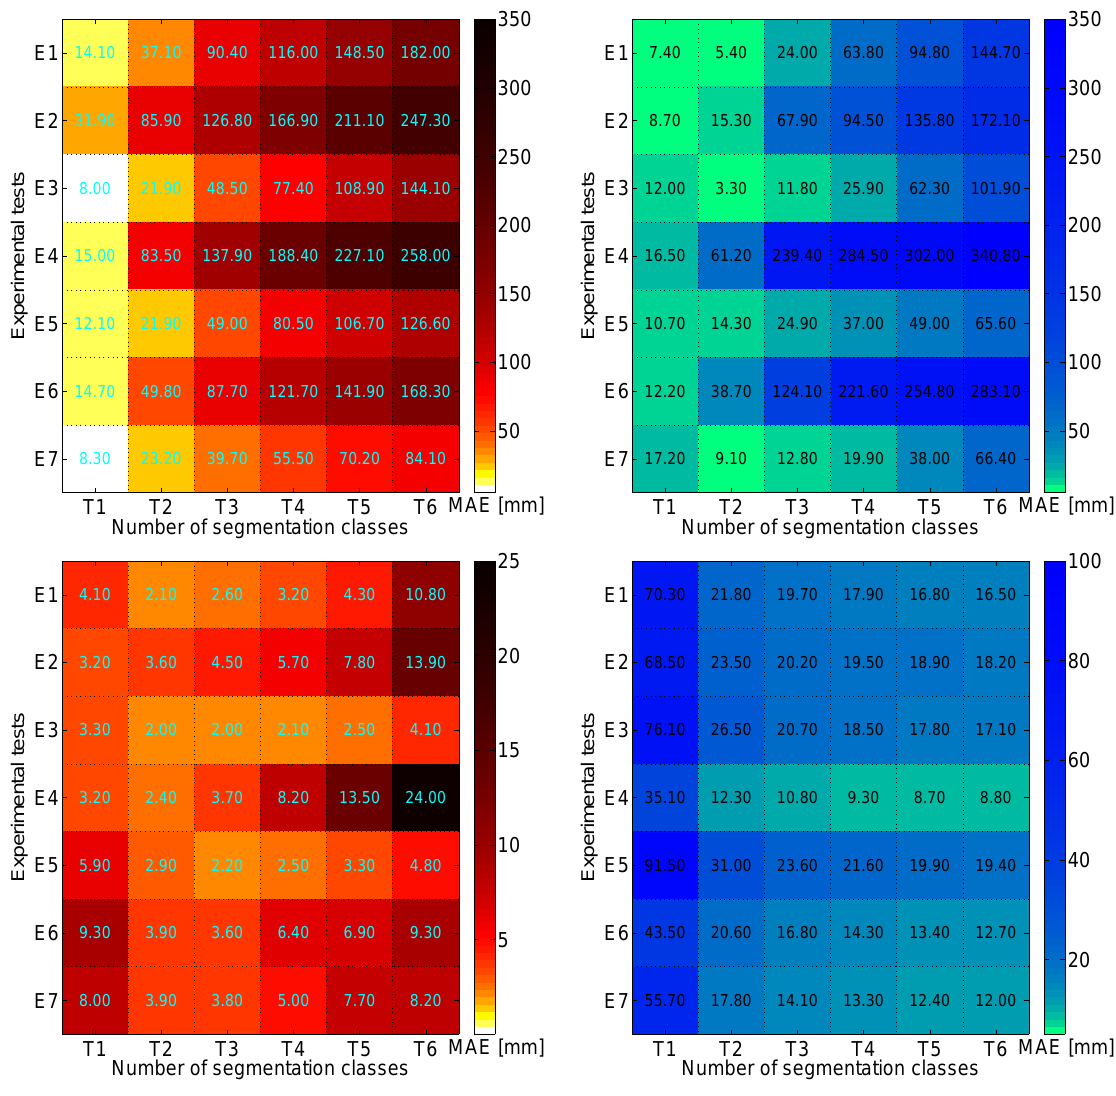
Figure 4. Mean absolute error (MAE) in mm between unfiltered and a priori known pole/white bar lengths for all experimental tests (E1 to E7). Left side heatmaps show values estimated from images of the pole in RGB ( top ) and NIR ( bottom ). Right side heatmaps show values estimated from images of the white bar in RGB ( top ) and NIR ( bottom ). Values are reported for all segmentation classes (T1 to